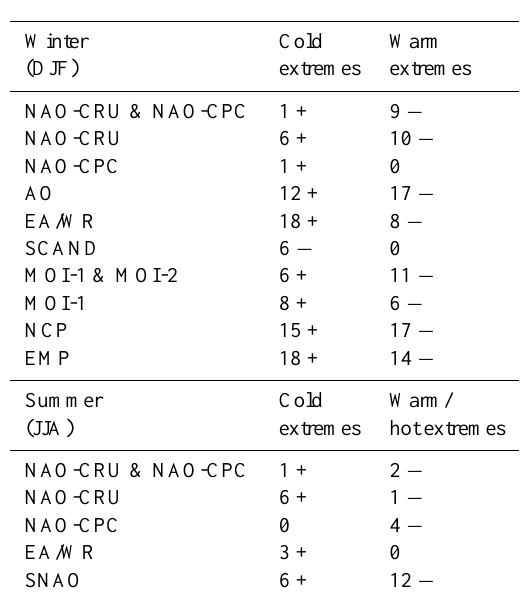
Table 9. Summary of the relationships identified in Table 7 (winter) and Table 8 (summer). The total number of times each circulation index appears is given for warm/cold (TN5n, TX5n, TG5n) and hot (TN95n, TX95n, TG95n) extremes together with the sign of the relationship (positive + or negative